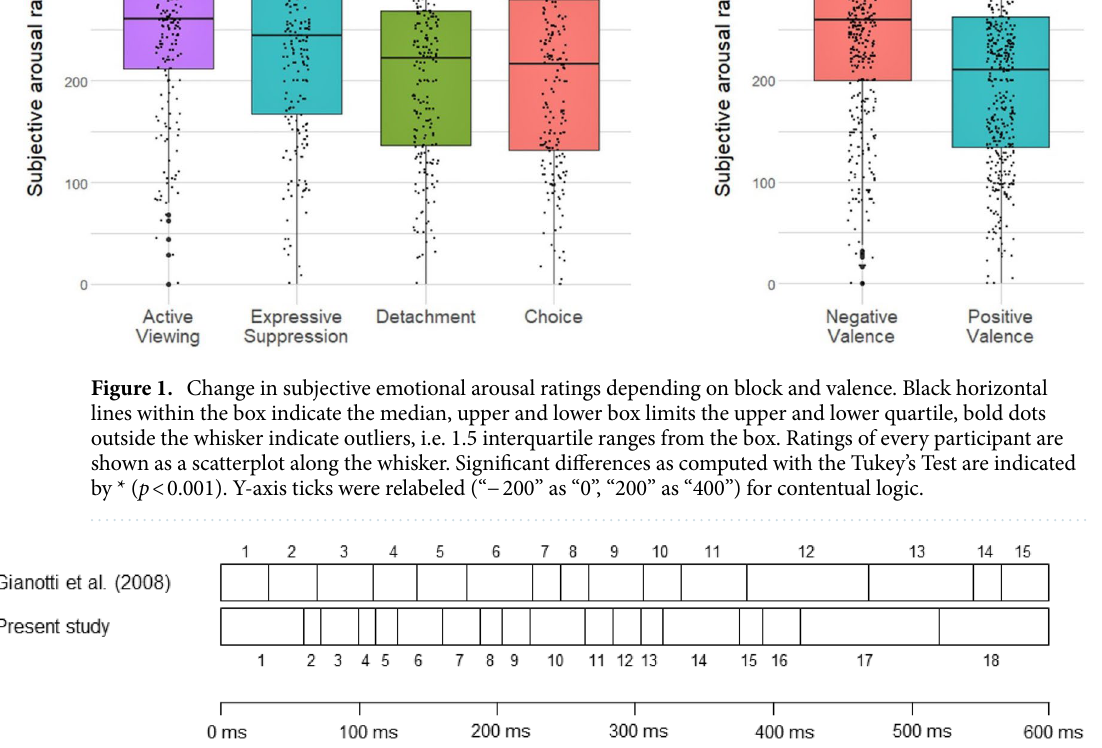
Figure 2. Temporal comparison of the microstates in both studies. Microstates as defined by the clustering of the grand–grandmean ERP. Cell length represents relative microstate length; numbers above or below denote the microstate number. Stimulus onset is at 0 ms.